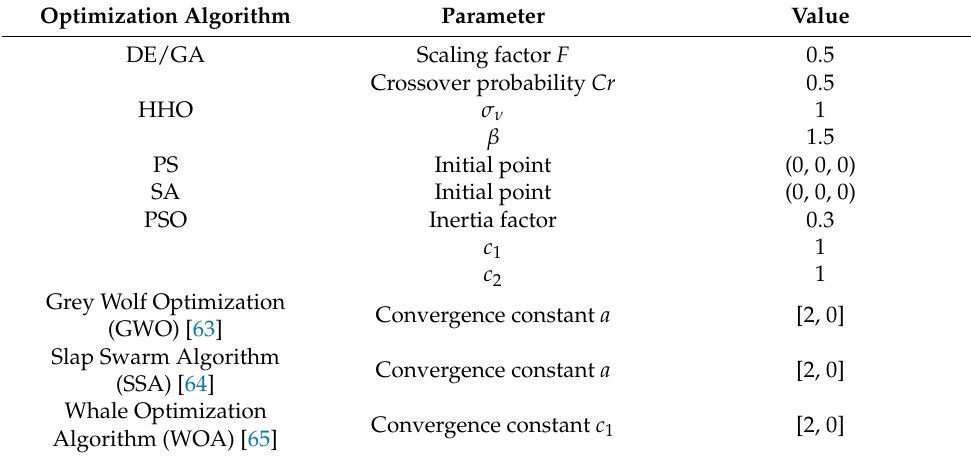
Table 7. The parameter settings.